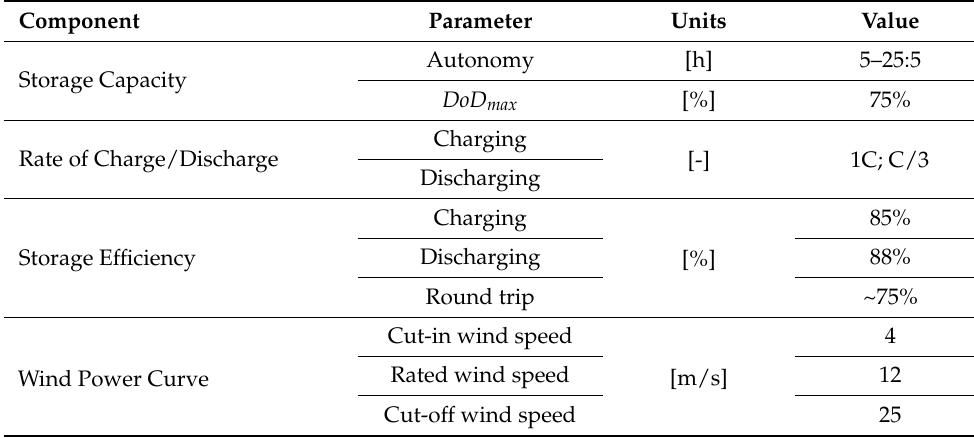
Figure 5. Wind–storage operational flow diagram. Table 3. Wind and storage components’ technical characteristics.